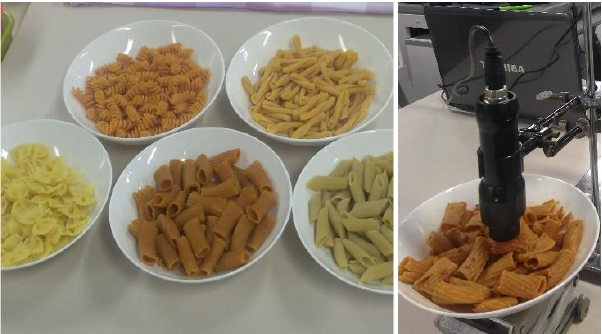
Figure 1. Different morphologies of the investigated pastas and a typical experimental set-up for the measurement of a pasta (here without sauce) with the handheld NIR spectrometer.